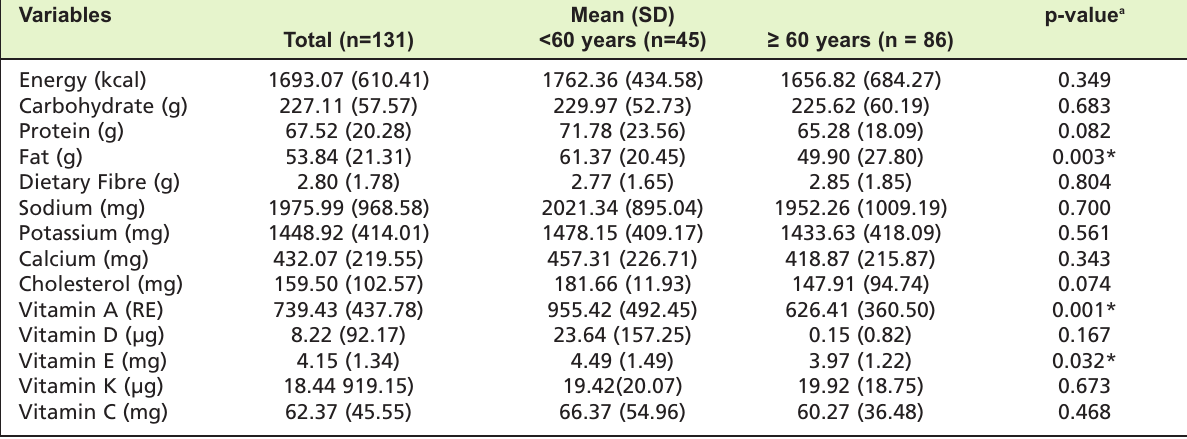
Dietary intake according to age group (n = Table IV: